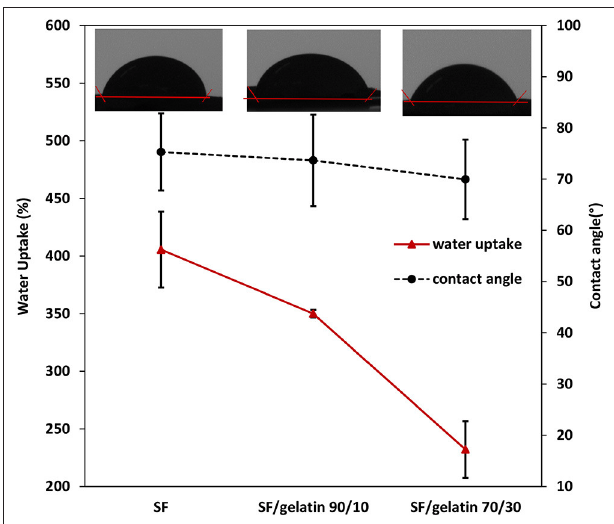
FIGURE 7 | Water uptake capacity for GTA crosslinked SF nanofiber mats and SF/gelatin nanofiber mats after 24h and corresponding contact angles.